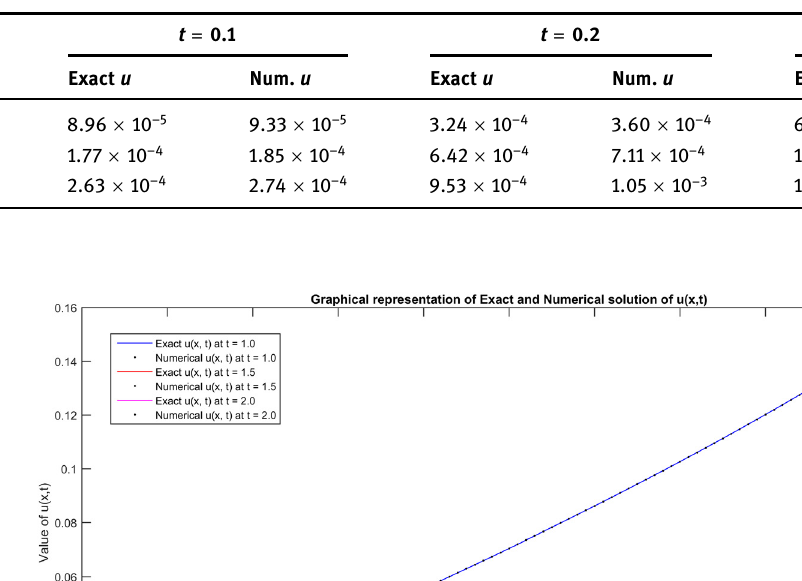
Table 8: Comparison of results at di ff erent node points and time levels regarding (